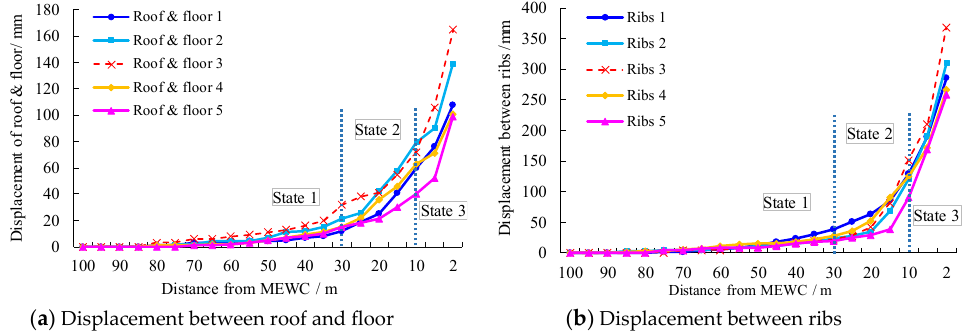
Figure 17. The curve of displacement monitoring.